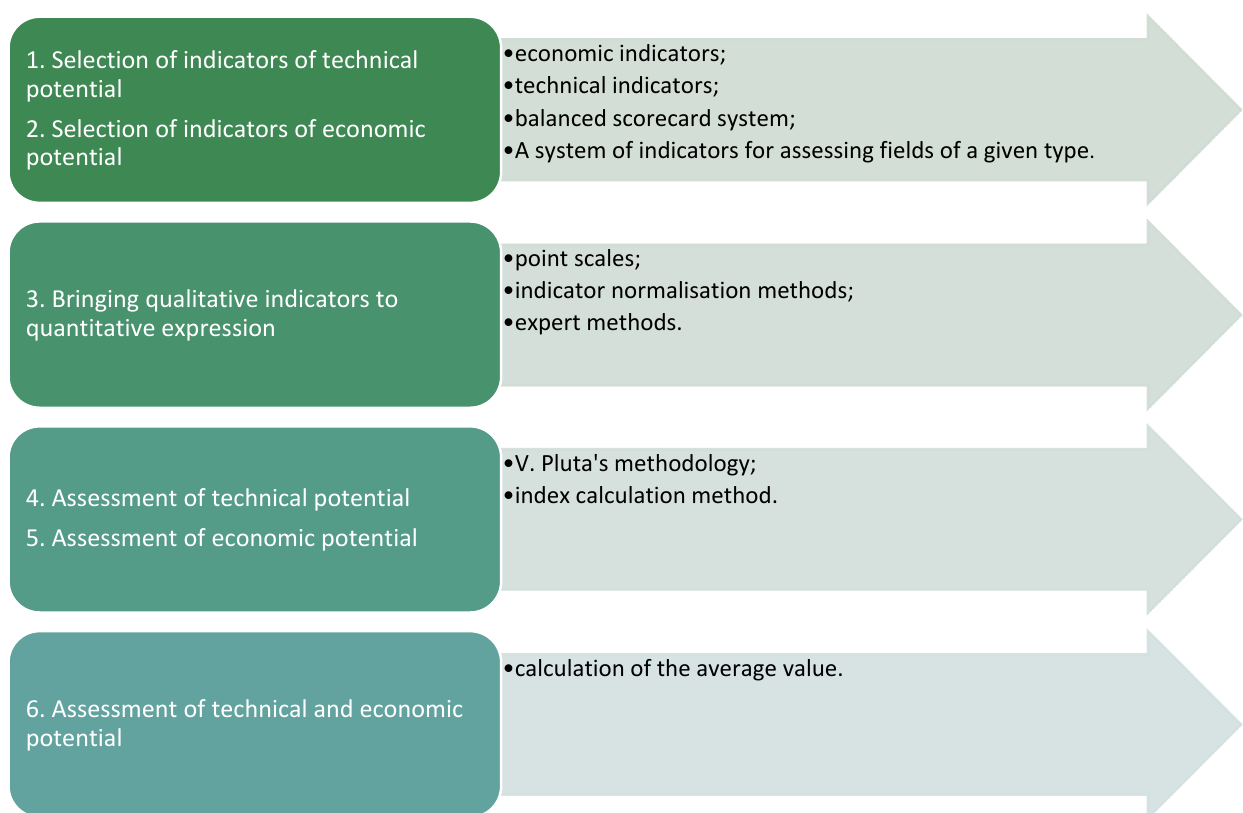
Figure 2. Multivariate implementation of stages in the assessment of the technical and economic potential of oil and gas fields in the Arctic.